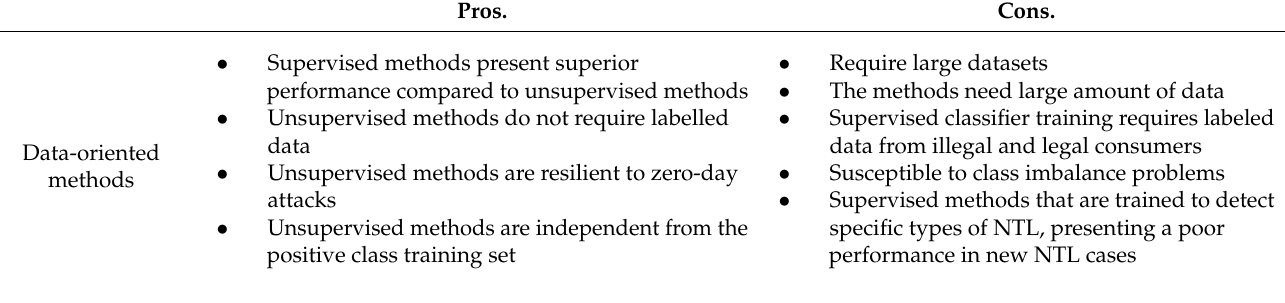
Table 6. Non-Hardware-Based NTL detection methods pros and cons summary. Pros.